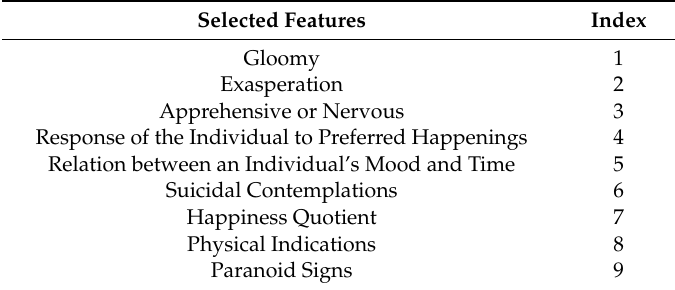
Table 2. Selected features and their indices for unipolar depression (UD) classification.